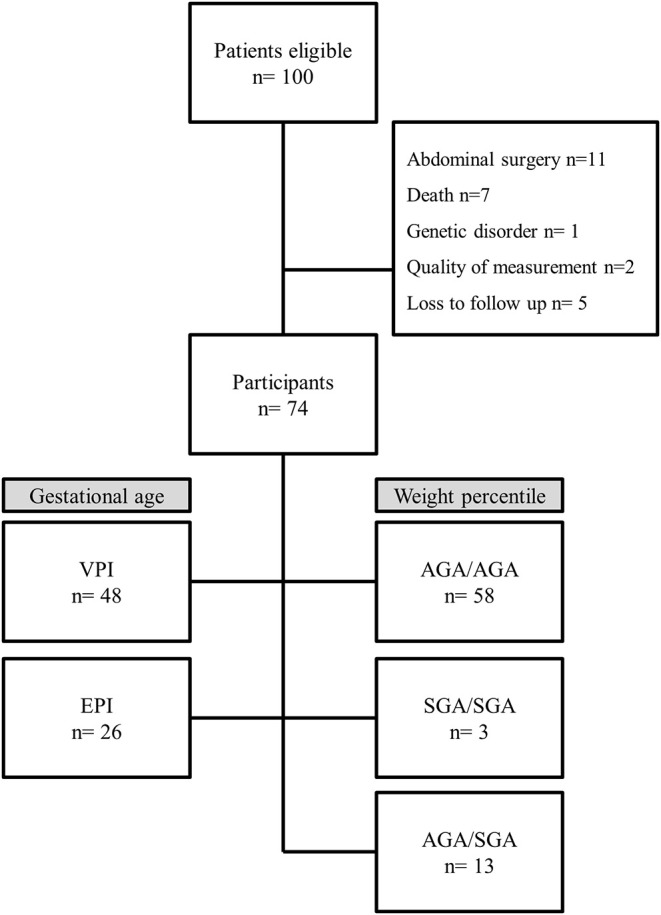
Flow chart. VPI, very preterm infants ≥28 weeks gestation; EPI, extremely preterm infants <28 weeks gestation; AGA/AGA, born and discharged appropriate for gestational age; SGA/SGA, born and discharged small for gestational age; AGA/SGA, born appropriate for gestational age and discharged small for gestational age.